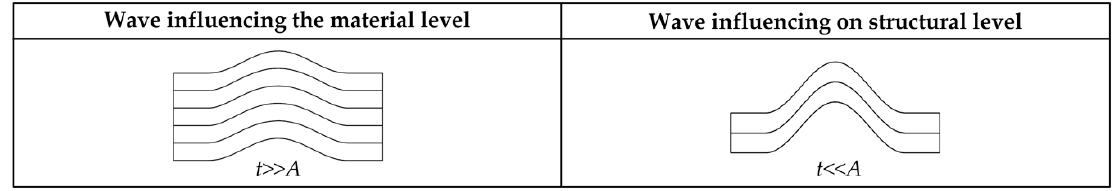
Figure 36. Material vs. structural level.